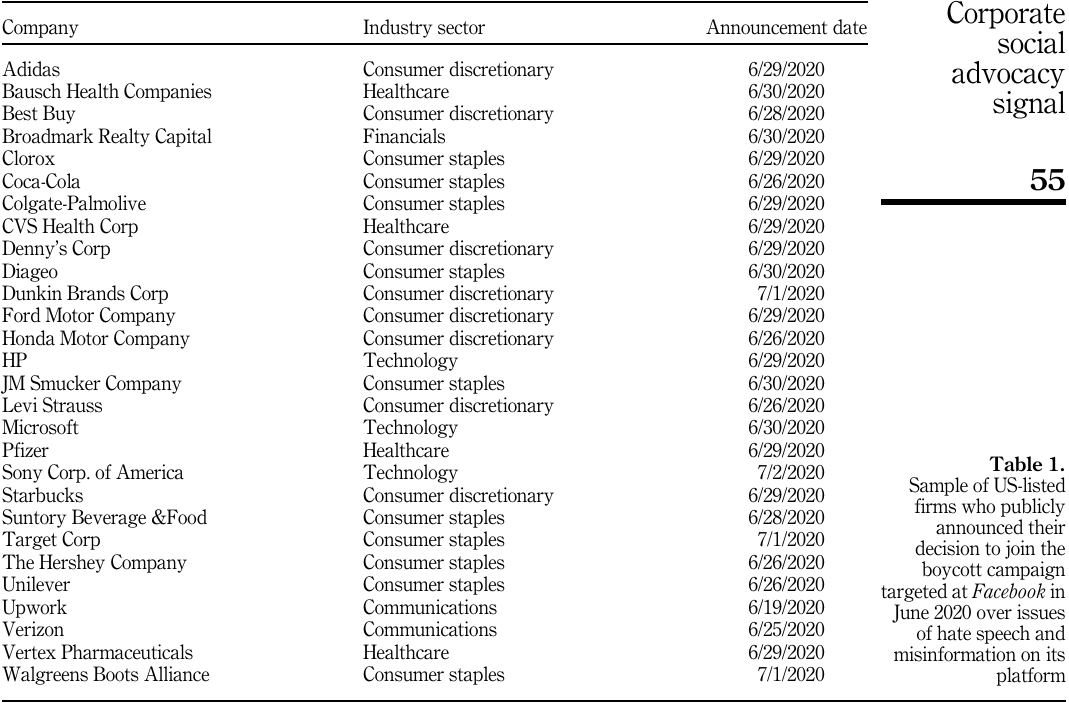
Table 1. Sample of